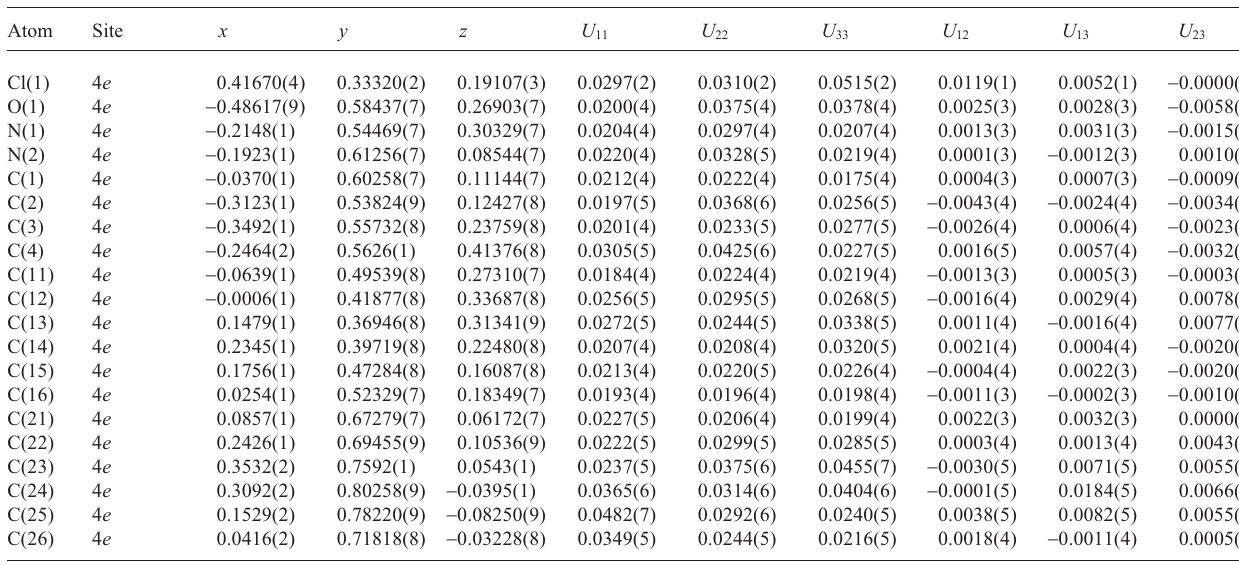
Table 3. Atomic coordinates and displacement parameters (in Å 2 )